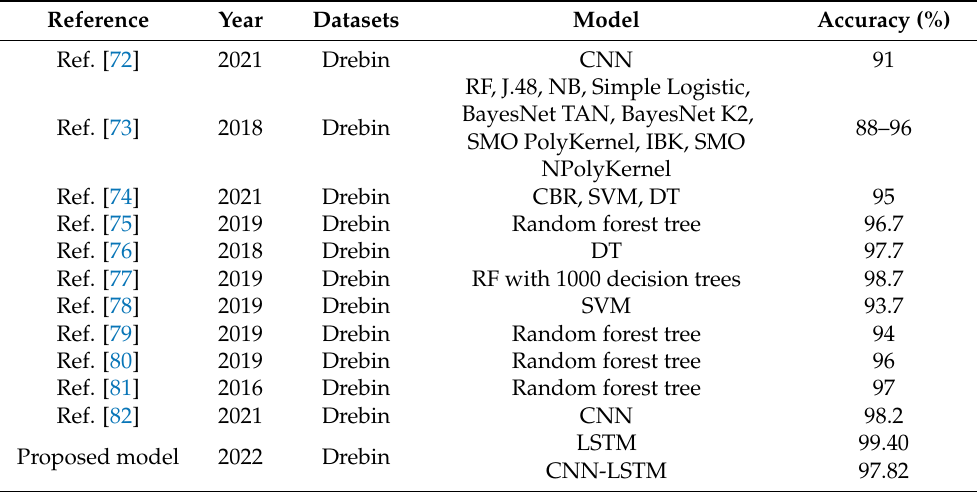
Table 13. Results of the proposed system against existing security systems using the Drebin